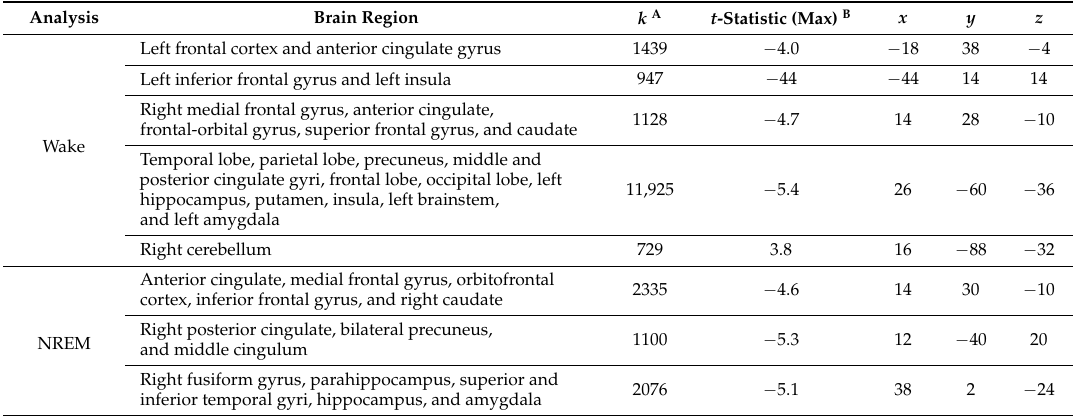
Table 1. Group (PI vs. GS) differences in relative glucose metabolism during wakefulness and NREM